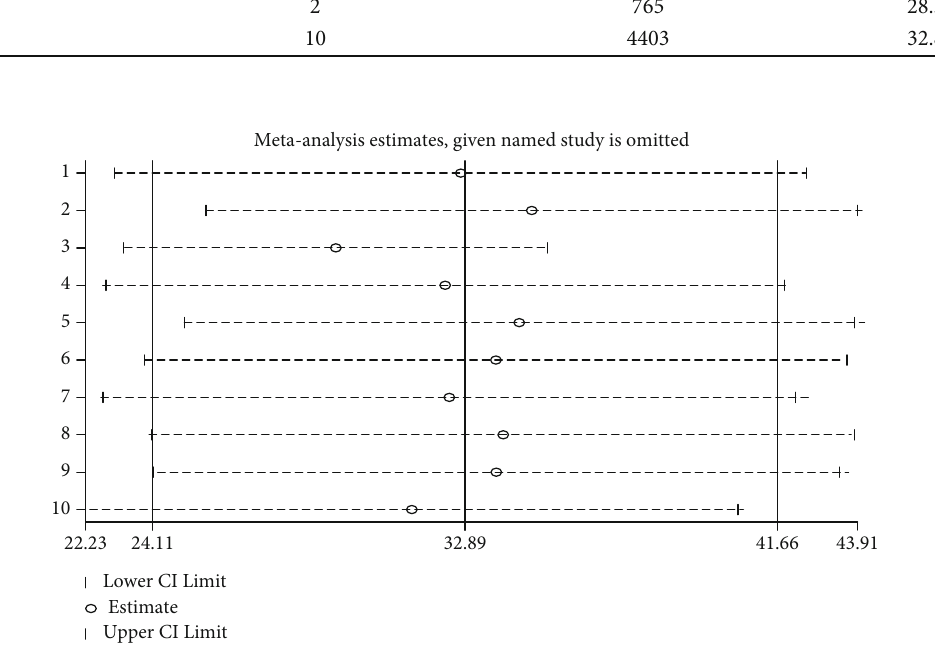
Figure 4: Sensitivity analysis for studies included in a systematic review and meta-analysis of Implanon discontinuation in Ethiopia, 2022.